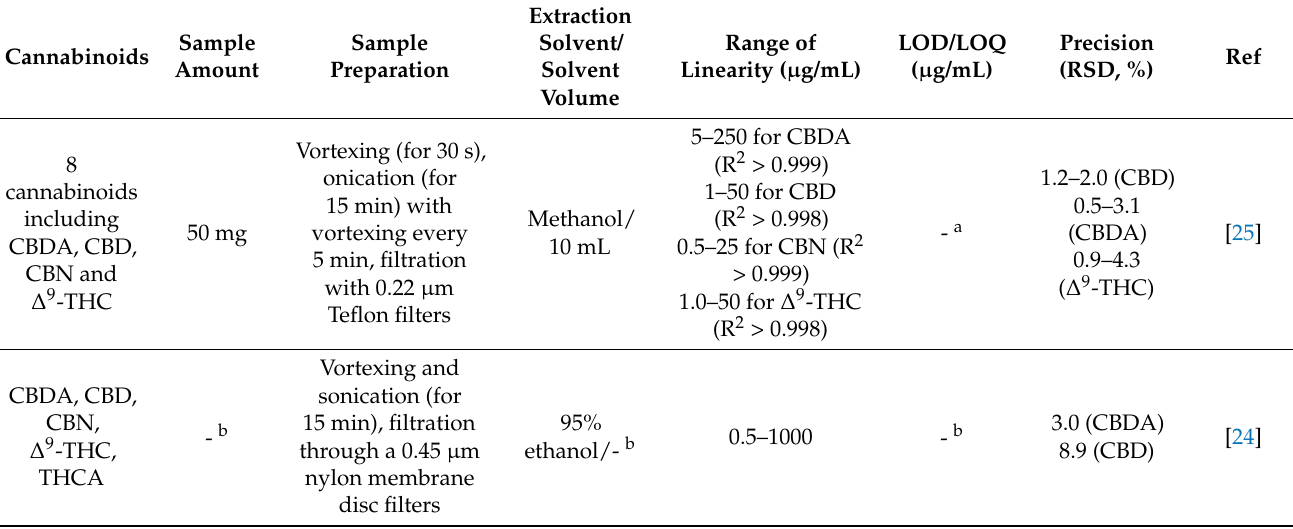
Table 3. Comparison of the proposed method with other methods for HPLC-DAD determination of cannabinoids in oil